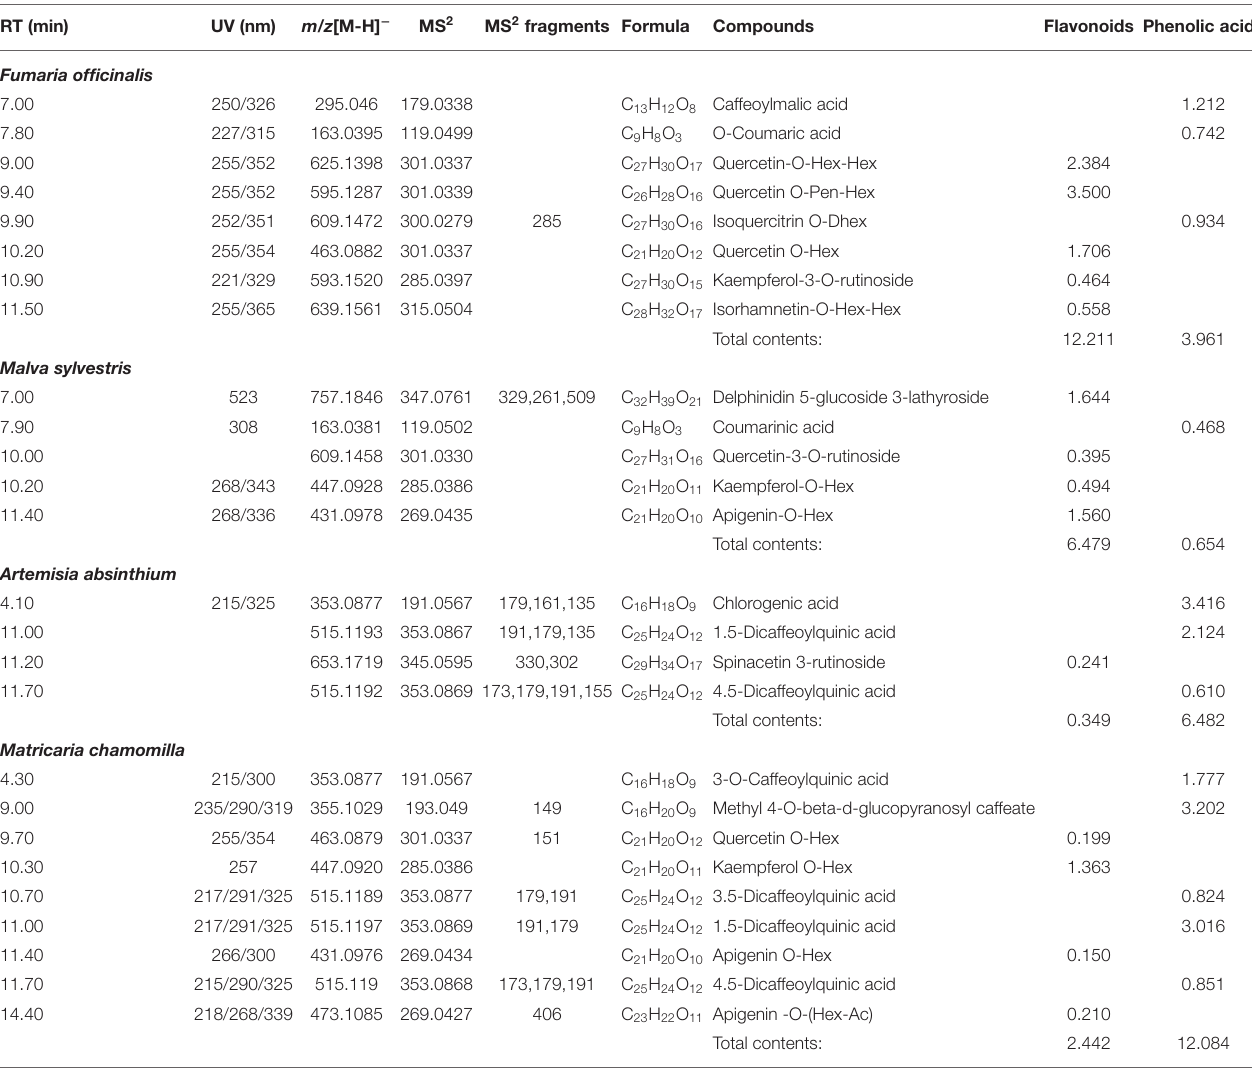
TABLE 2 | Concentrations of the main bioactive compounds in medicinal herbs (g/kg DM).